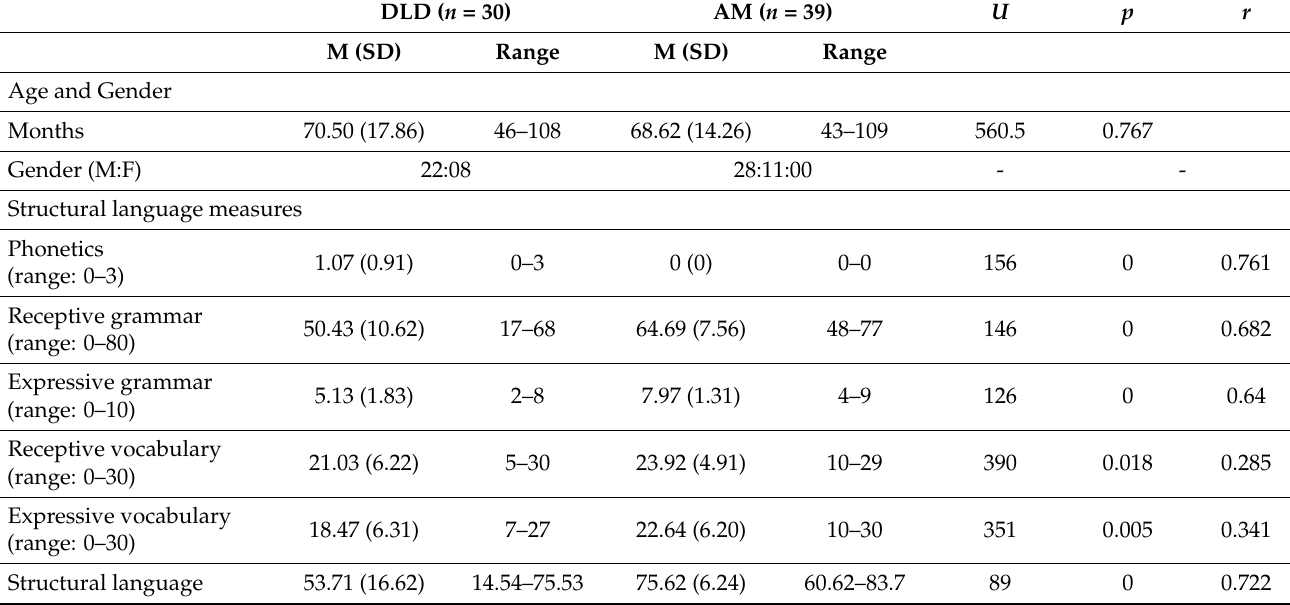
Table 2. Descriptive statistics of Developmental Language Disorder (DLD) and chronological Age-Matched (AM) groups and between-group comparisons on formal